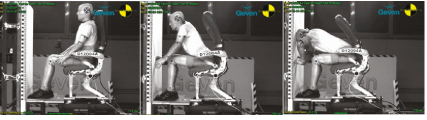
Figure 1: Experimental test.